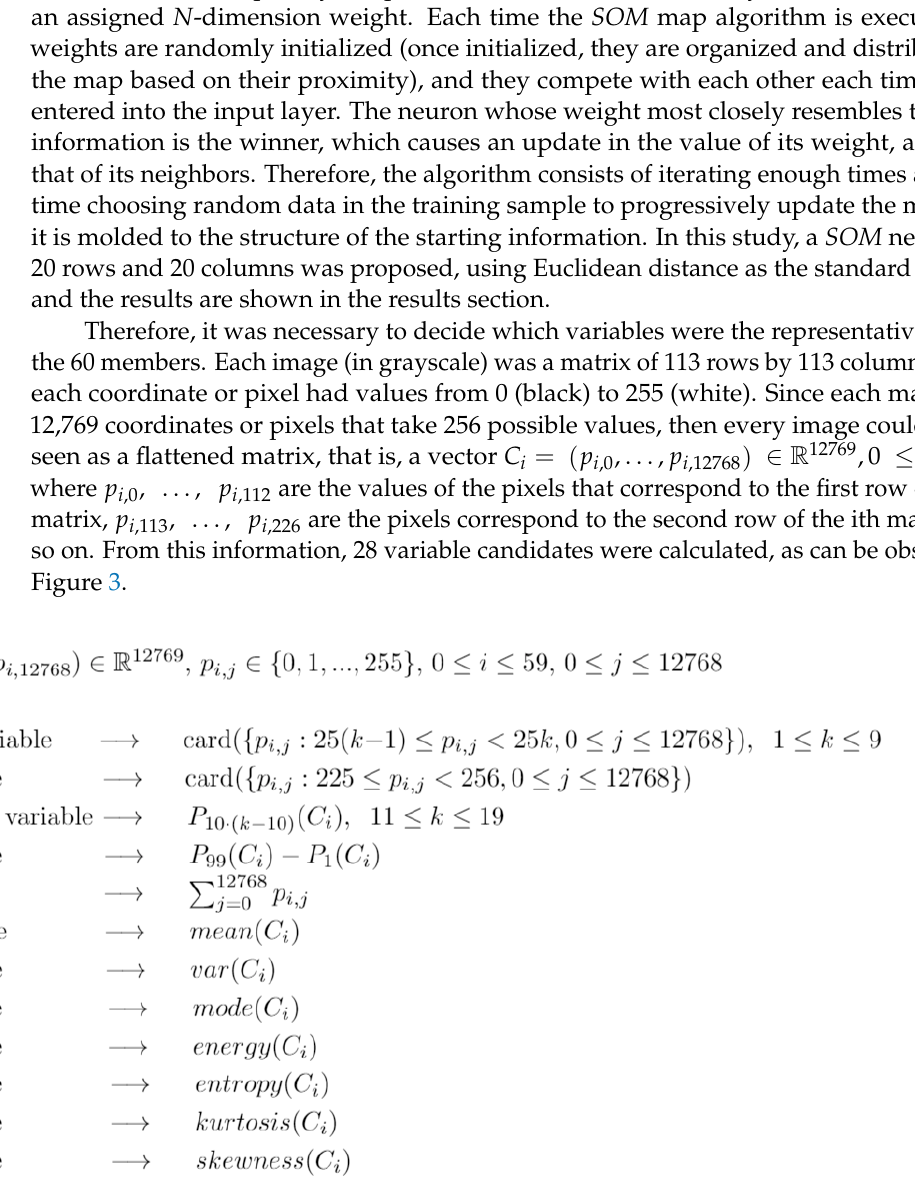
Figure 3. Pseudocode of the procedure for selecting the most significant variables.